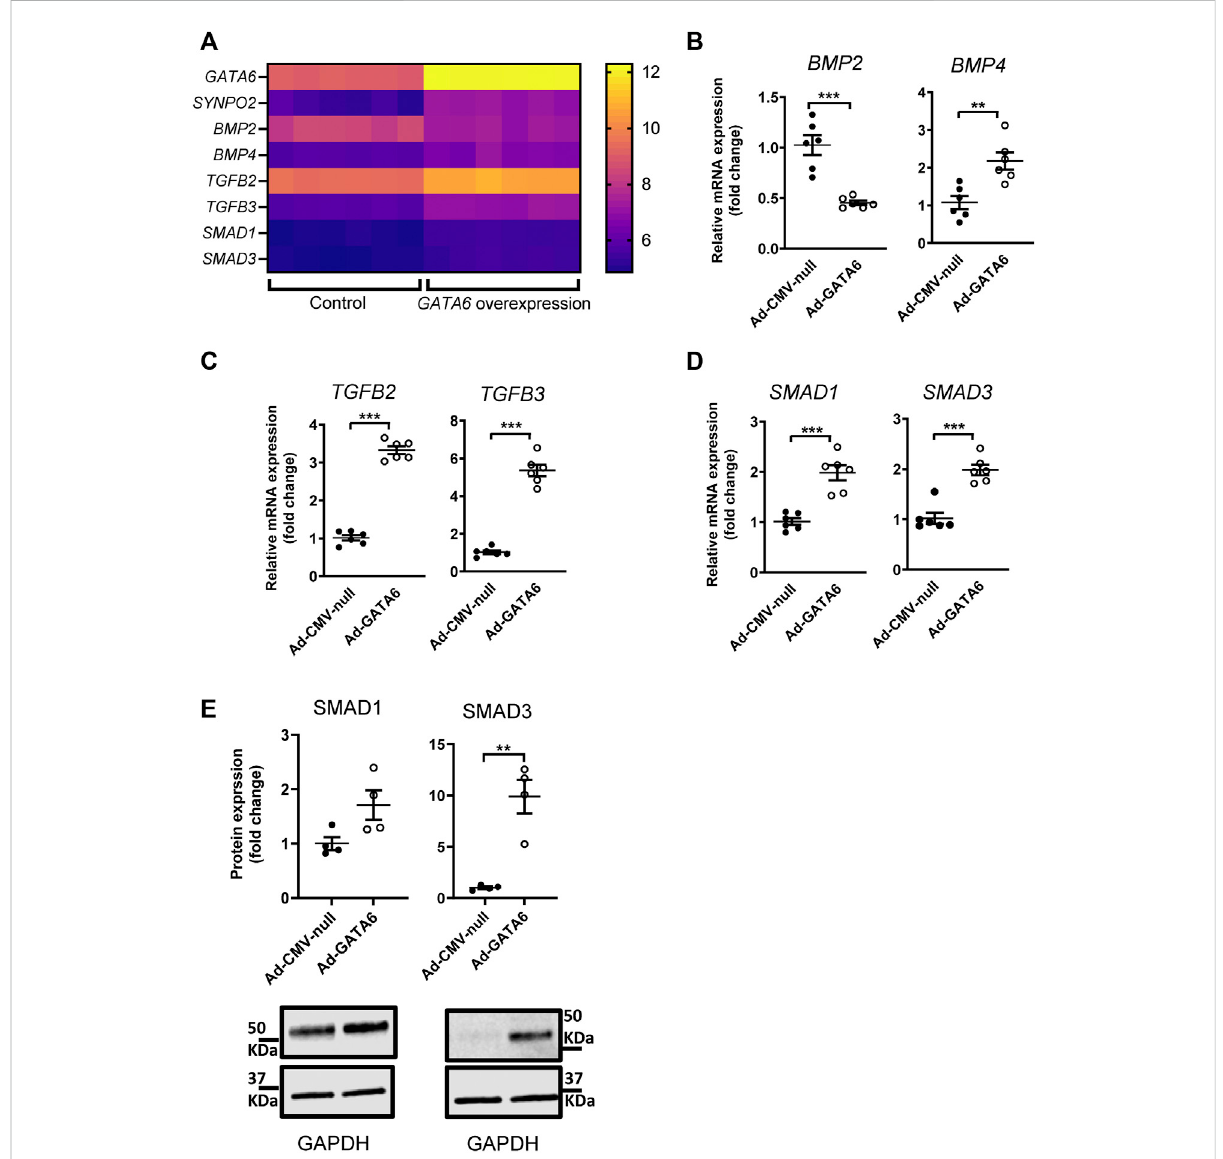
FIGURE 4 Identi fi cationofgenesregulatedbyGATA6expression.AcompletemicroarrayscreenofGATA6-sensitivegenetranscriptionwasperformedon human coronary artery smooth muscle cells transduced with 100 MOI Ad-CMV-GATA6 or Ad-CMV-null (vehicle) as a control. Expression values for selected genes from the microarray from each sample ( n = 6) (A) . Validation of selected genes by qRT-PCR (B – D) and western blot (E) . Data are presented as mean ± SEM ( n = 6). ** p < 0.01, *** p <